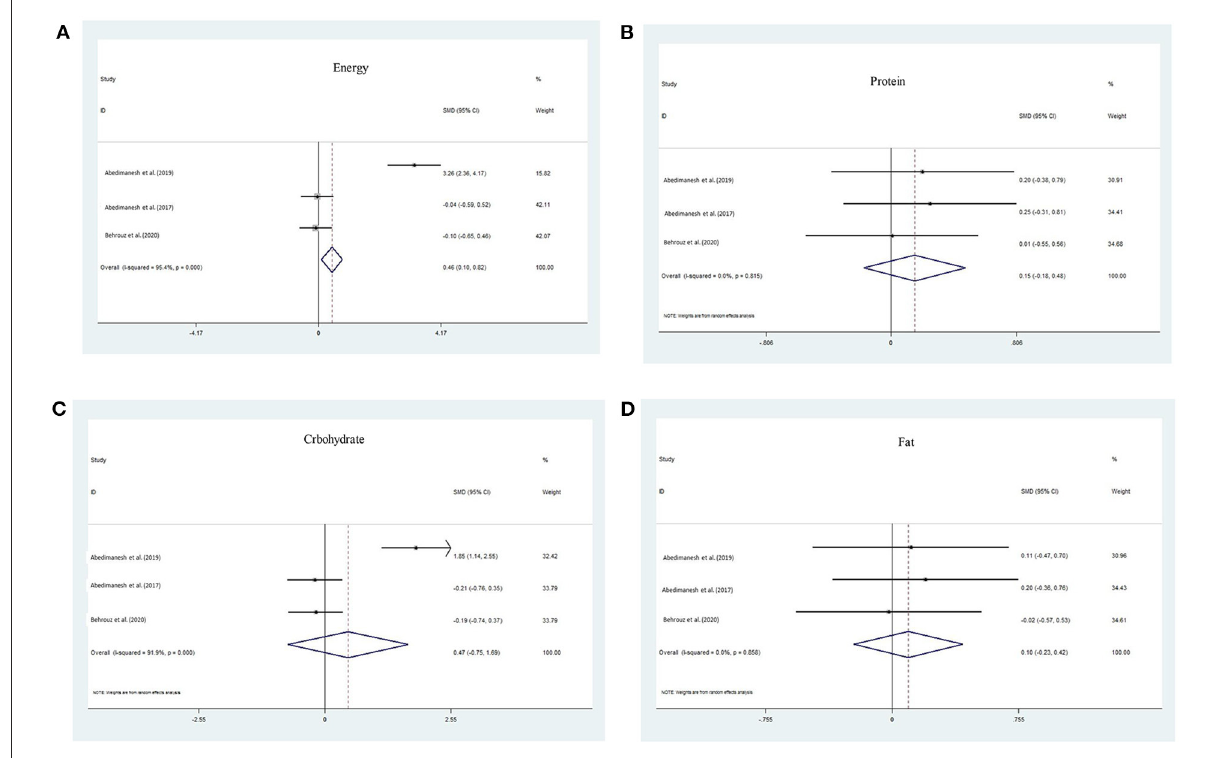
FIGURE3 The association between crocin and crocetin and (A) Energy, (B) carbohydrate, (C) protein, and (D) fat.